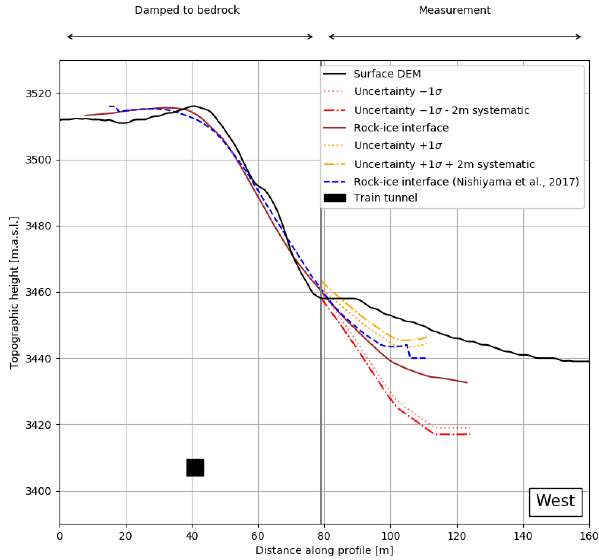
Figure 6. Western cross section. The brown and dashed blue lines indicate the ice–bedrock interface solutions of this study and the one from Nishiyama et al. (2017), respectively. The 1 σ error margins are shown in yellow (upper) and red (lower). The dotted margins encompass only the statistical variation of the interface position, whereas the dash-dotted margins include a ± 2m systematic error which stems from the inherent DEM uncertainty. For completeness, we also show the position of the railway tunnel as a black